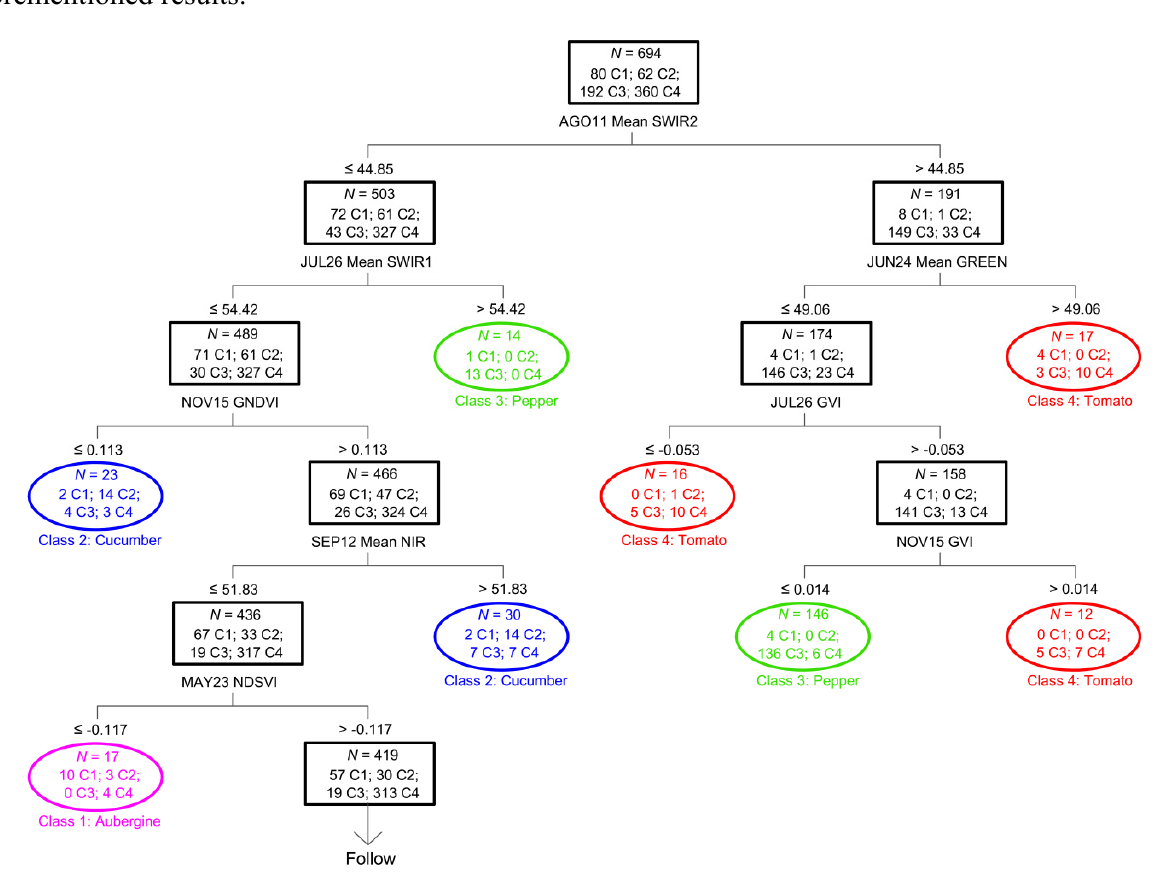
Figure 6. Decision tree computed for the Landsat 8 time series dataset and no GLCM strategy. Only nine out of 34 terminal nodes are shown. N is the number of objects in each node, Class 1 (C1) = aubergine, C2 = cucumber, C3 = pepper, C4 = tomato. AGO11, 11 August; JUL26, 26 July; JUN24, 24 June; NOV15, 15 November; SEP12, 12